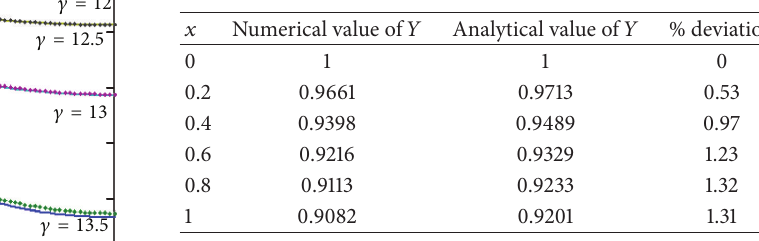
Figure 4: Dimensionless temperature T versus dimensionless spa- tial coordinate x using (6) for Le = 0.233, 𝛽 = 4.287 𝜙 2 = 1000, and various values of 𝛾 . Solid lines represent the analytical solution, whereas the dotted lines are for the numerical solution. Table 1: Comparison between analytical and numerical values of dimensionless concentration 𝑌 (Le = 0.233 , 𝛽 = 4.287 , 𝛾 = 13.6 , and 𝜙 2 = 30000